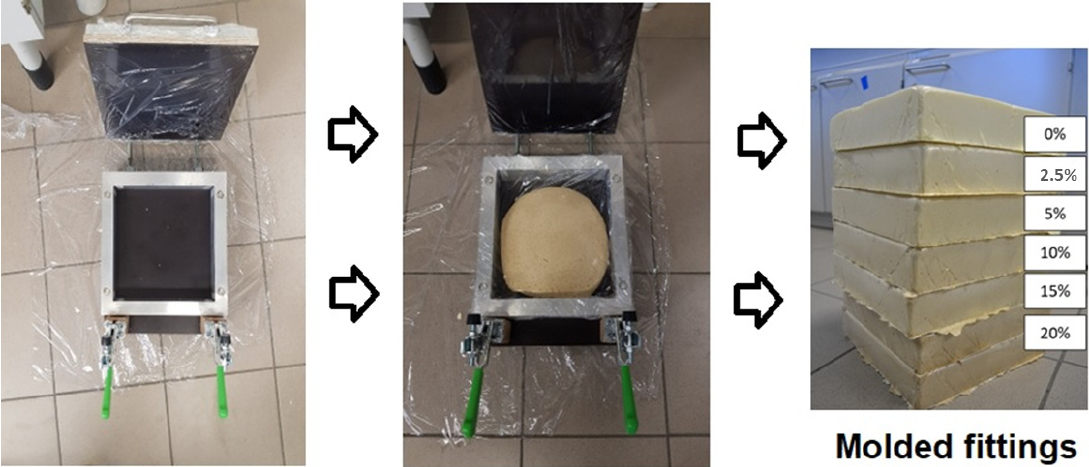
Figure 1. Preparation of moulded samples.